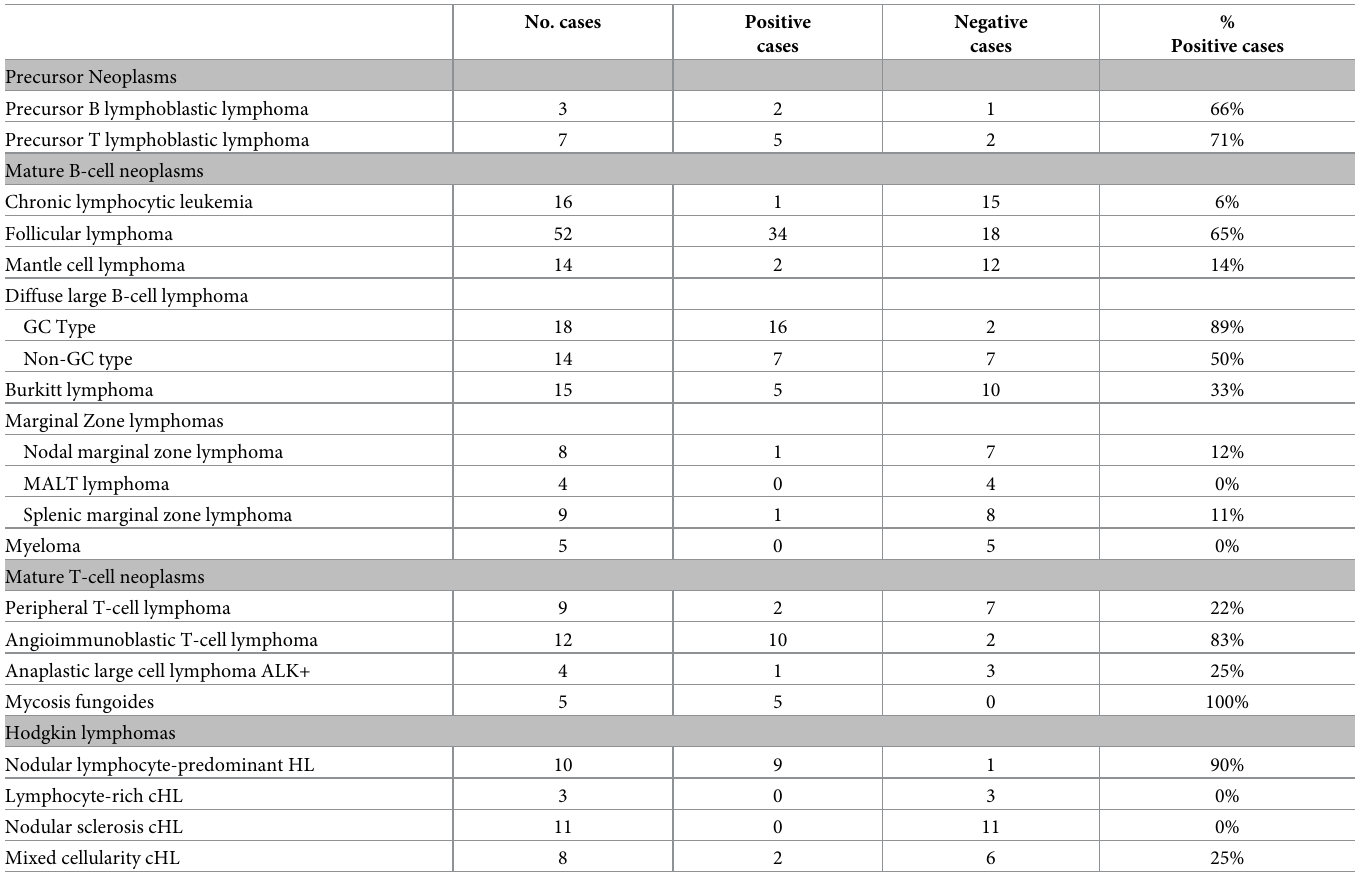
Table 2. TOX expression in lymphomas.